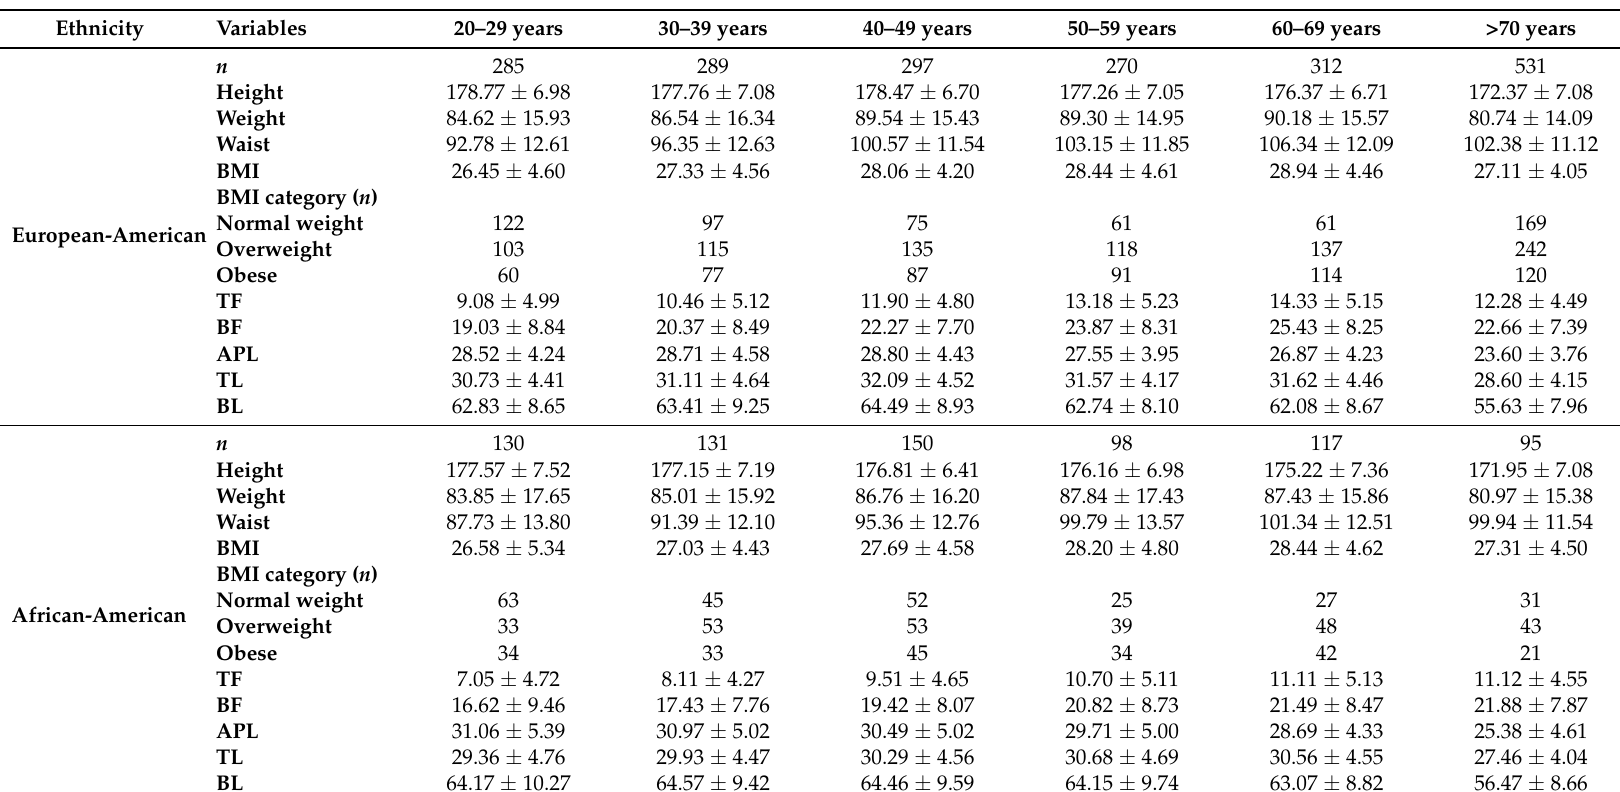
Table 4. Men’s segmental body composition variables (mean ± standard deviation) obtained by DXA in National Health and Nutrition Examination Surveys (NHANES) and classified by age and